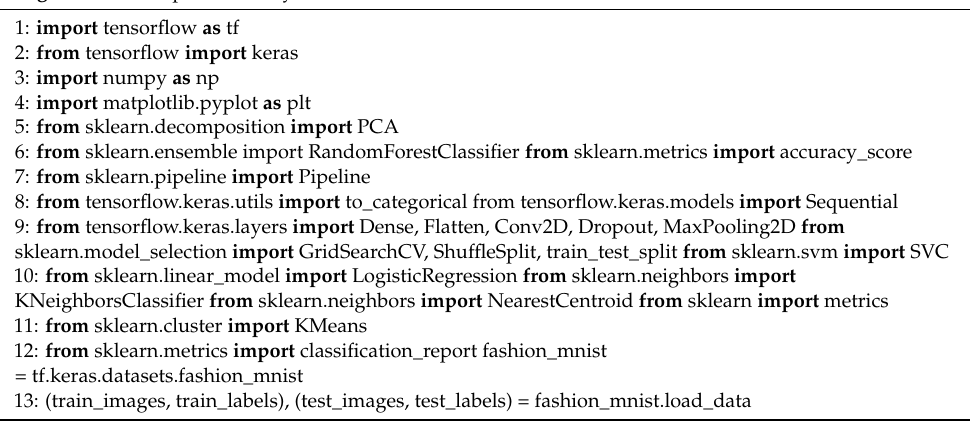
Algorithm 2 Component Analysis